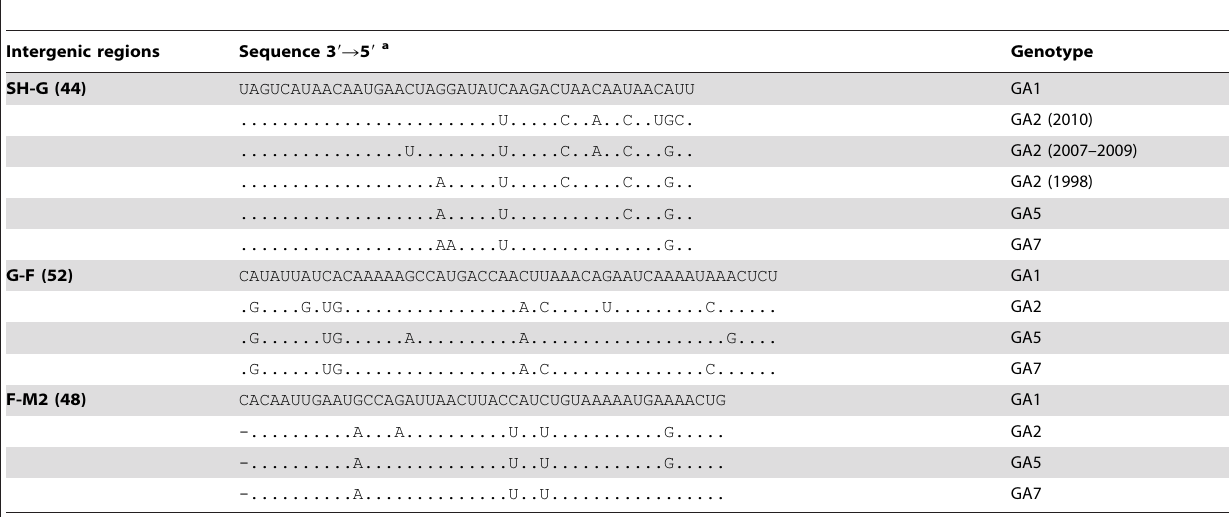
Table 4. Intergenic region sequences for RSV A strains from Milwaukee and genotype patterns.